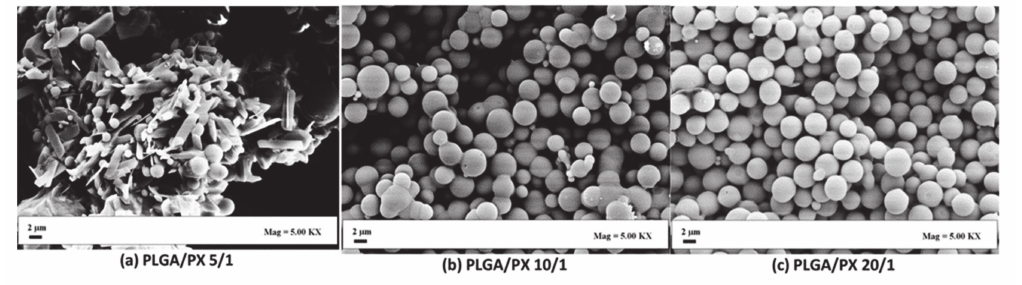
Figure 8. Piroxicam-loaded PLGA particles produced by SAILA with varying polymer / drug ratio of ( a ) 5:1 ( b ) 10:1 and ( c ) 20:1 (scale 2 µ m). Reprinted with permission from [108], Elsevier, 2017.